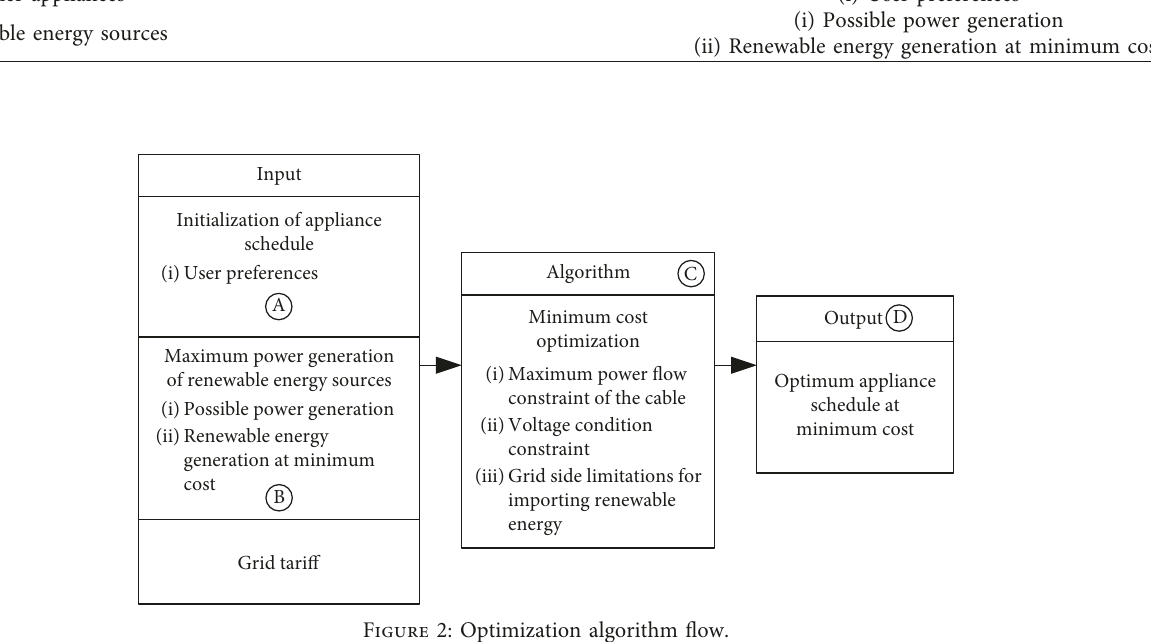
Figure 2: Optimization algorithm